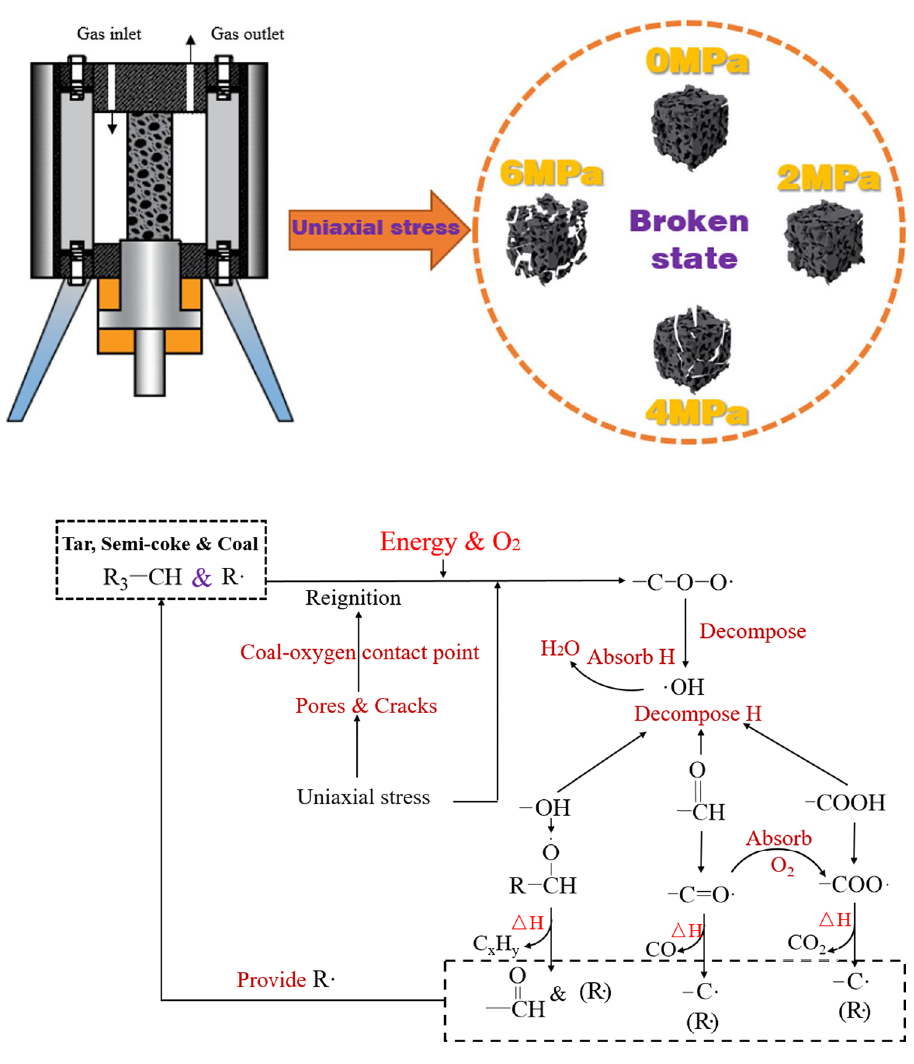
Fig. 8 The broken shape of bro- ken coal under uniaxial stress